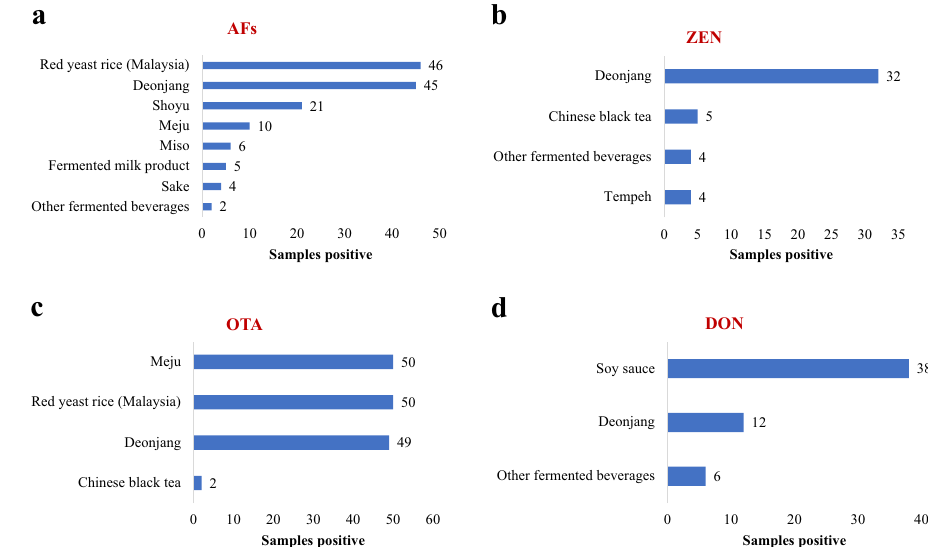
Fig. 2 Incidence of mycotoxin contamination in Asian fermented foods. a Frequency of AFs contamination in Asian fermented foods samples. b Frequency of ZEN contamination in n Asian fermented foods samples. c Frequency of OTA contamination in Asian fermented foods samples. d Frequency of DON contamination in Asian fermented foods samples. AFs A fl atoxins, ZEN Zearalenone, OTA Ochratoxin A, DON